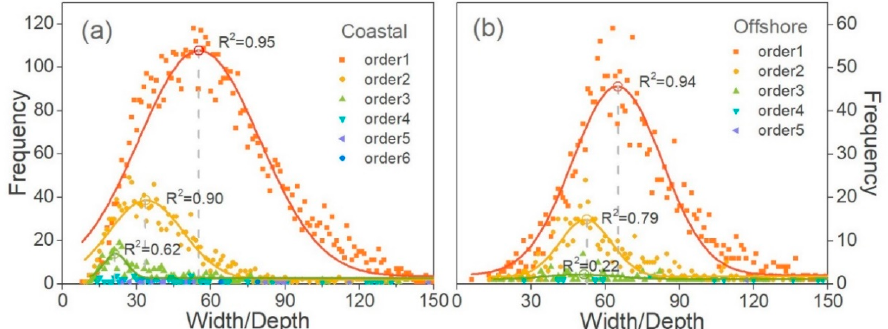
Figure 9. Frequency distributions of the width/depth ratio of coastal ( a ) and offshore ( b ) tidal creeks of different order. The red, yellow and green curves are the regression results for first-order, second-order and third-order creeks, respectively.